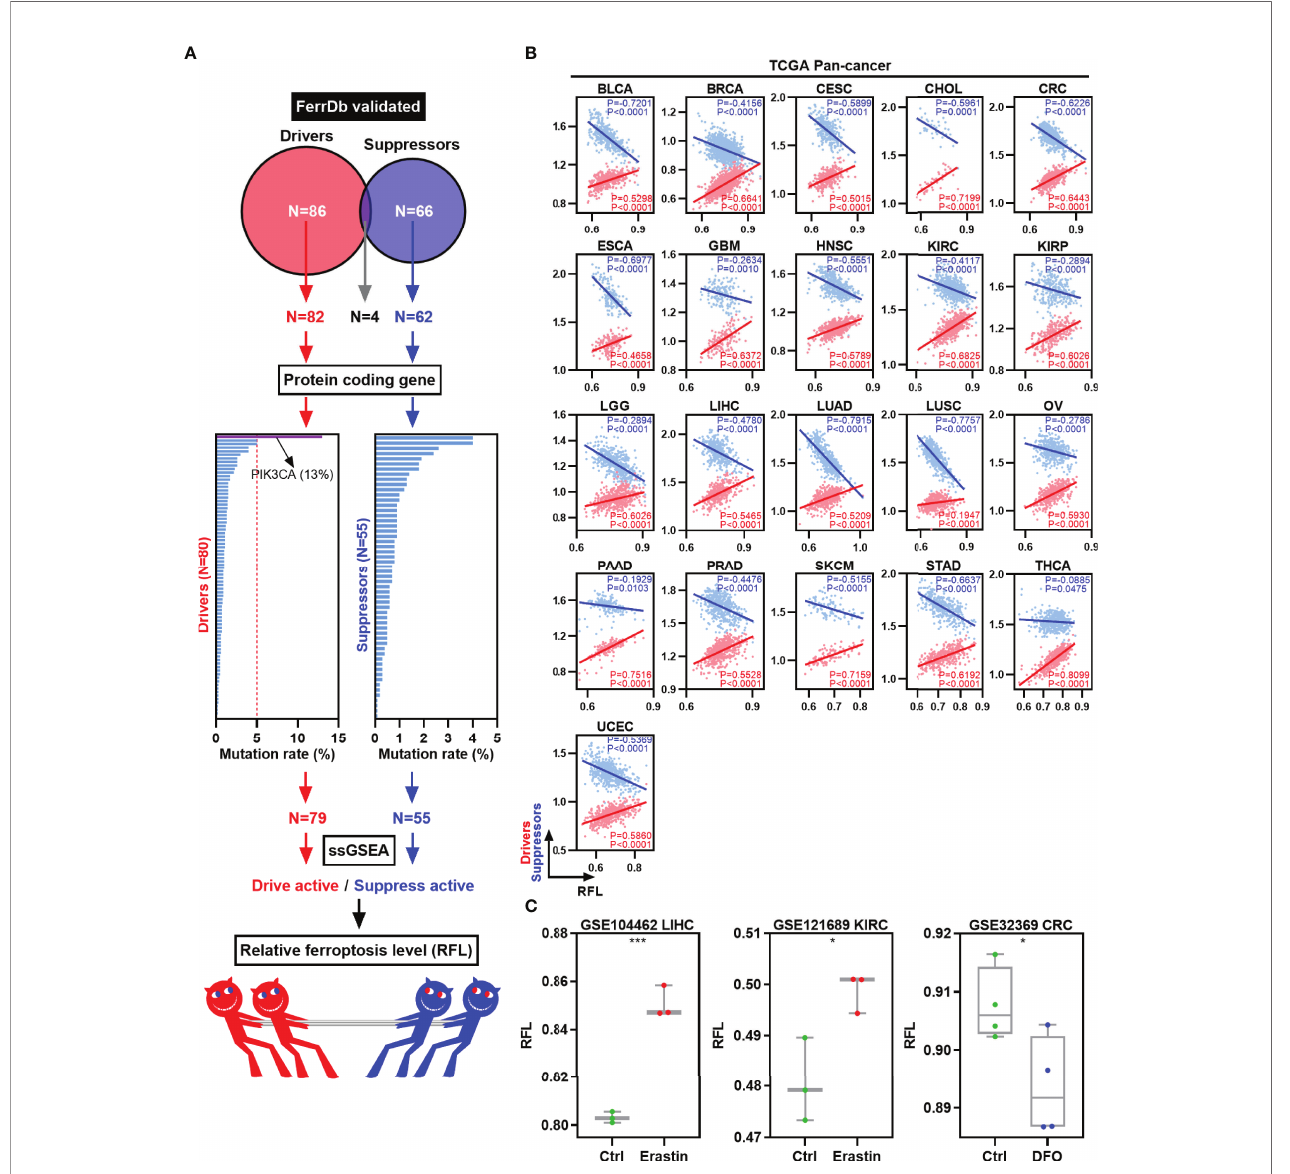
FIGURE 1 | Establishment and validation of RFL in human cancers. (A) Graph showing how the RFL was constructed. (B) Correlations between RFL and ferroptosis drivers/suppressors active level across human cancers in the TCGA. (C) Box plots showing the RFL level in GSE104462, GSE121689, and GSE32369 datasets of cancer cells grouped by Erastin/DFO and control. *P< 0.05, **P < 0.01, ***P <0.001, ****P <